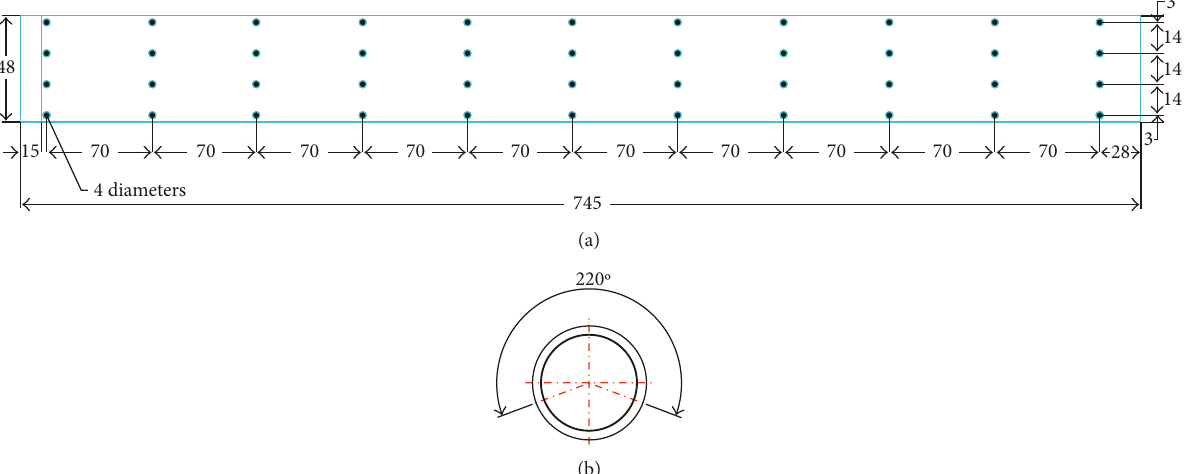
Figure 3: Details of perforations in the HDPE pipe. (a) Placement of perforations on the HDPE pipe and (b) partial pipe drainage.